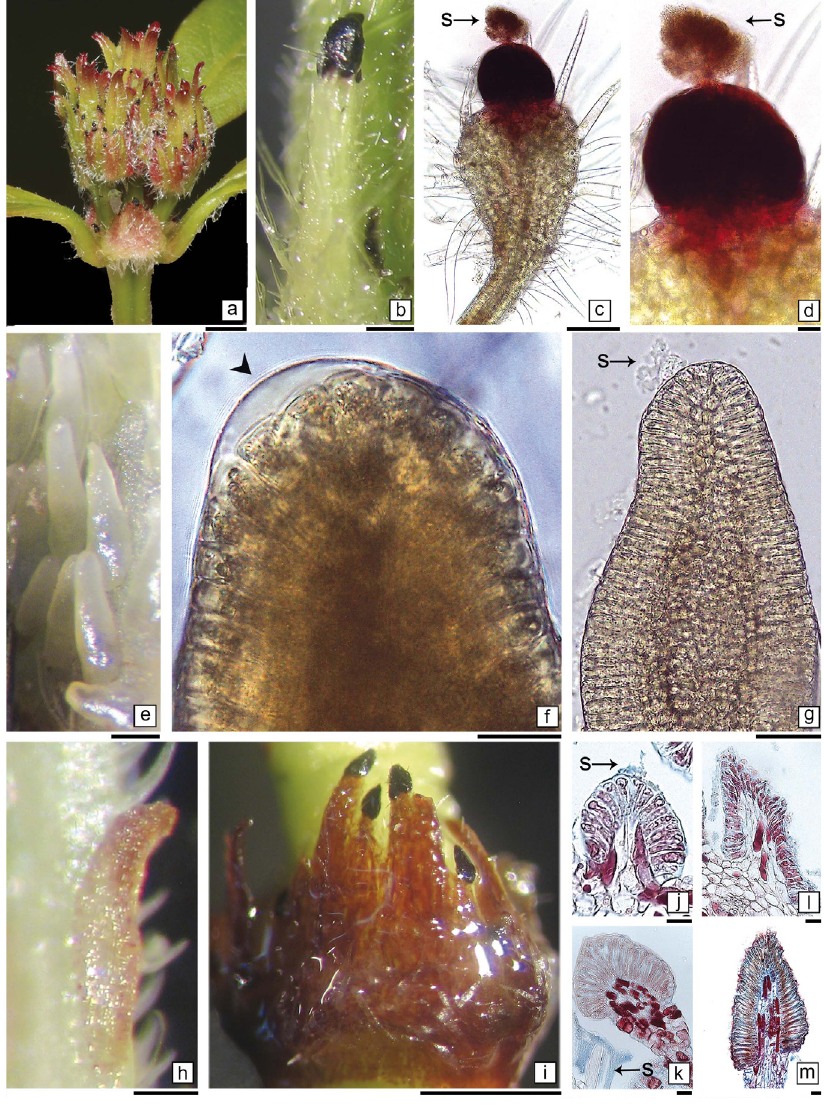
Figure 3. Secretion of the colleters in C. glabratus : in fresh material (a, b) , LM (c, d, f, g, j-m) and stereoscopic microscope (e, h, i) . (a) Vegetative apex with DC at the apex of young stipules. (b) Turgid DC at the apex of the stipule. (c) Bracteole with secreting DC at the apex. (d) Detail of the LC showing blackish-red secretion. (e) Turgid LC. (f) LC with colorless secretion between the cuticle and epidermal cells ( arrowhead ). (g) LC with colorless secretion released. (h) LC withered and brownish. (i) Brown bract with DC in its senescent phase. (j-k) Anatomy of colleters during their secretory phase. (j) LC. (k) DC. (l-m) Anatomy of the colleter in its senescent phase. (l) LC. (m) DC. Abbreviation: s secretion. Scale bars a, h, i = 1 mm; b = 300 µm; c, e = 100 µm; g = 50 µm; d, f, j-m = 20